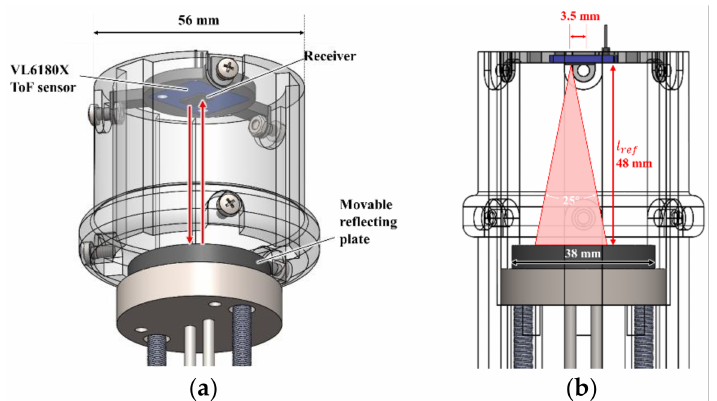
Figure 5. ( a ) Middle part for measuring moving distance of movable reflecting plate, connecting upper and lower parts of sensor body, and facilitating users to hold it. ( b ) Viewing cone of infrared receiver at ToF sensor